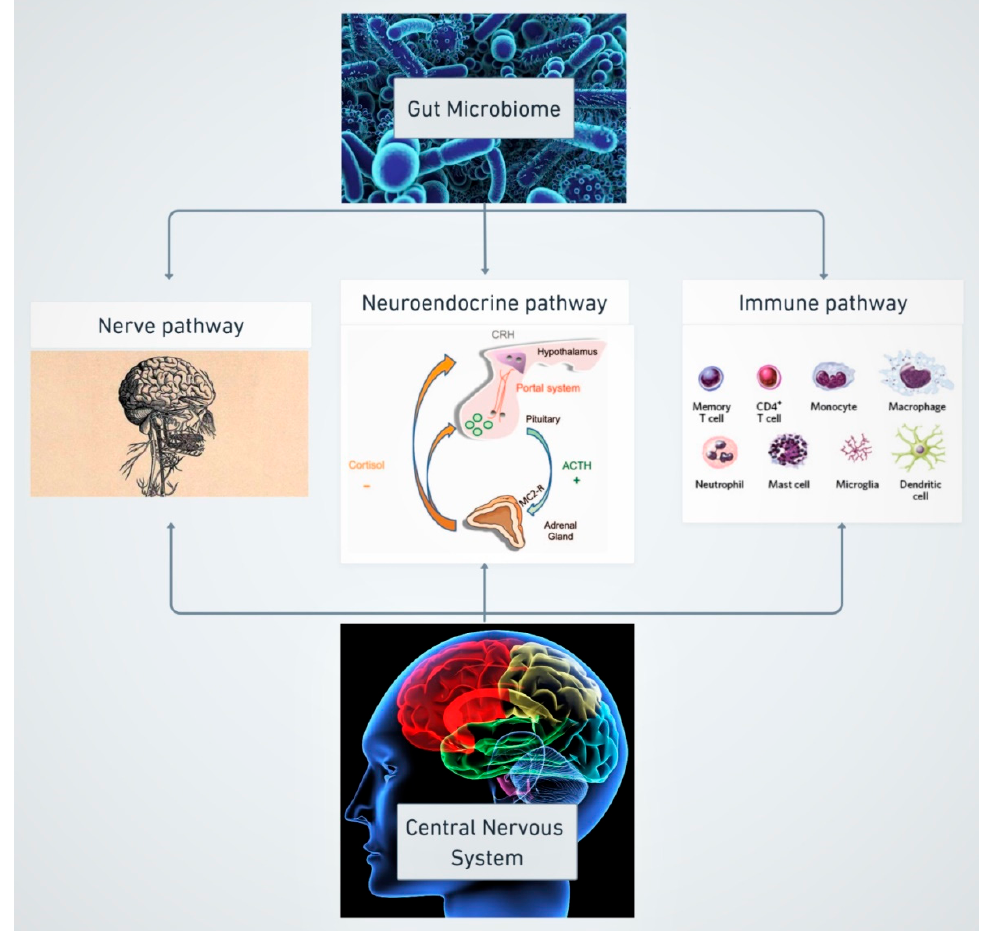
Figure 1. Schematic diagram of the three pathways (nerve, neuroendocrine and immune) that configure the microbiome–gut–brain axis. CRH: corticotropin-releasing hormone; ACTH: adrenocorticotropic hormone; MC2-R: melanocortin receptor 2. CD4+ T cell: CD4-positive T cell.